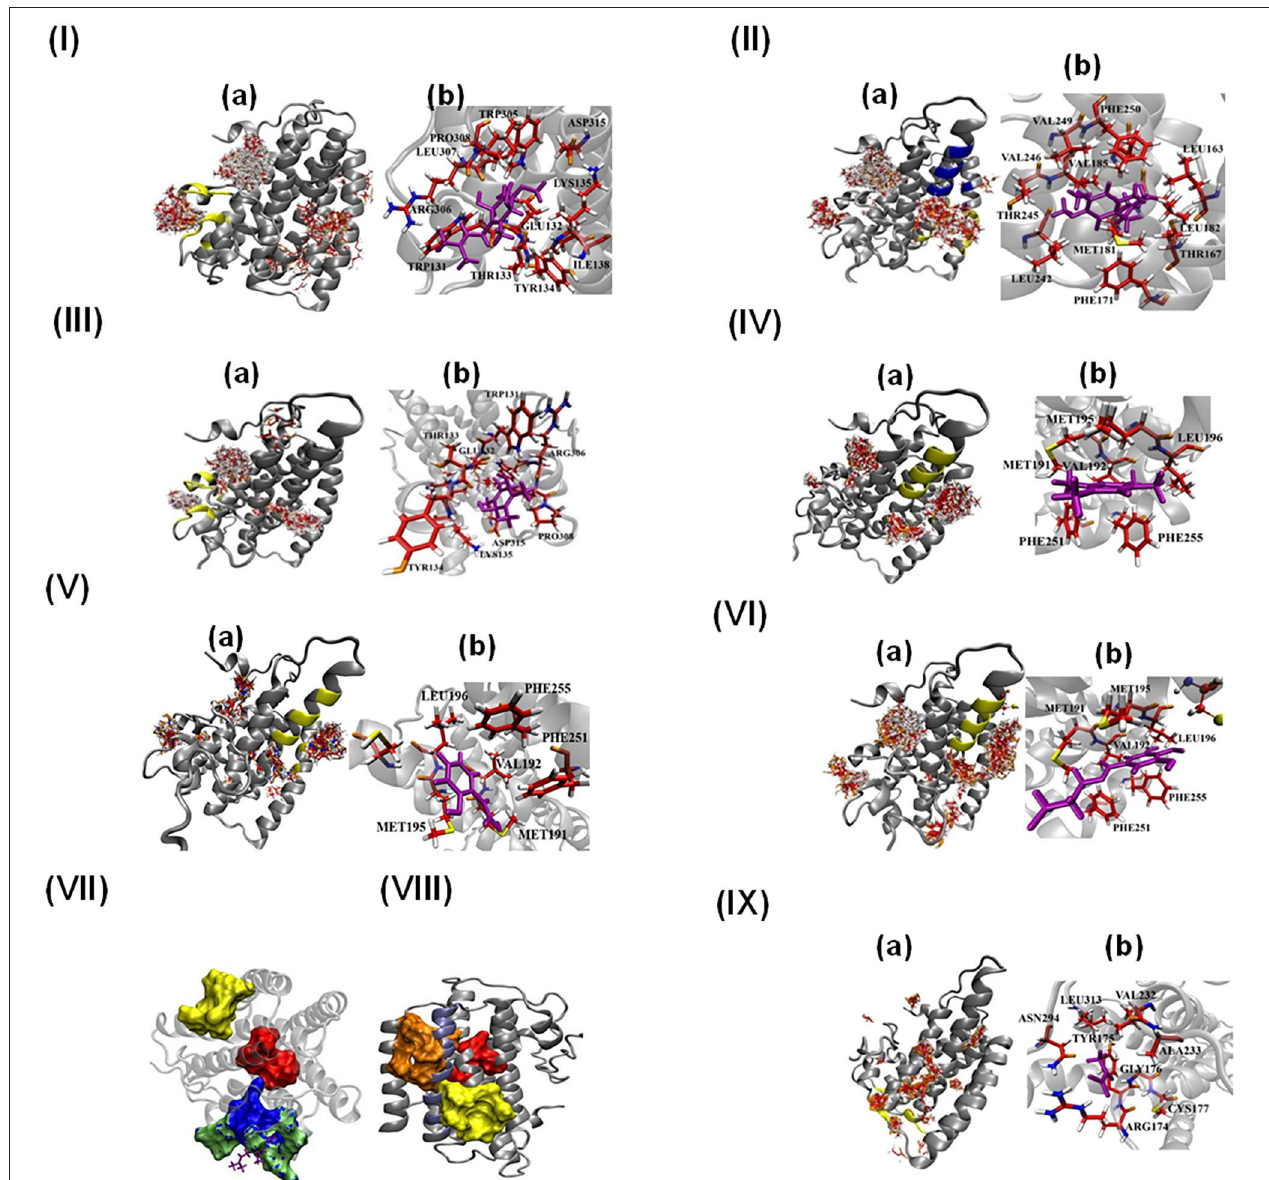
FIGURE 6 | Molecular docking of AtAOX1A with different ligands (I-VI and IX) . (a) All possible binding pockets of a specific ligand on AtAOX1A. The yellow region on AtAOX1A secondary structure indicates the best-fit binding pocket of a particular ligand. The Blue region in panel (IIa) represents the inhibitor binding pocket to compare with that of UQ, and (b) residues of AtAOX1A that are involved in forming the binding pocket of the best model (Cluster 0 Element 0) according to SwissDock results. The ligands are (I) Q 1 H 2 , (II) UQ 1 , (III) DQH 2 , (IV) DQ, (V) SHAM, (VI) n-PG, (VII) Binding pockets of inhibitor (yellow), DQH 2 (green surface), Q 1 H 2 (blue surface), and diiron binding cavity (red surface). DQH 2 is shown with purple sticks. (VIII) Binding pockets of inhibitor (yellow surface), ubiquinone-1 (orange surface), and diiron cavity (red surface), (IX) Pyruvate. Q 1 H 2, UQ 1 , DQH 2, DQ, SHAM, n-PG, and pyruvate are shown in purple. Color scheme: carbon (red), oxygen (orange), sulfur (yellow), nitrogen (blue), and hydrogen